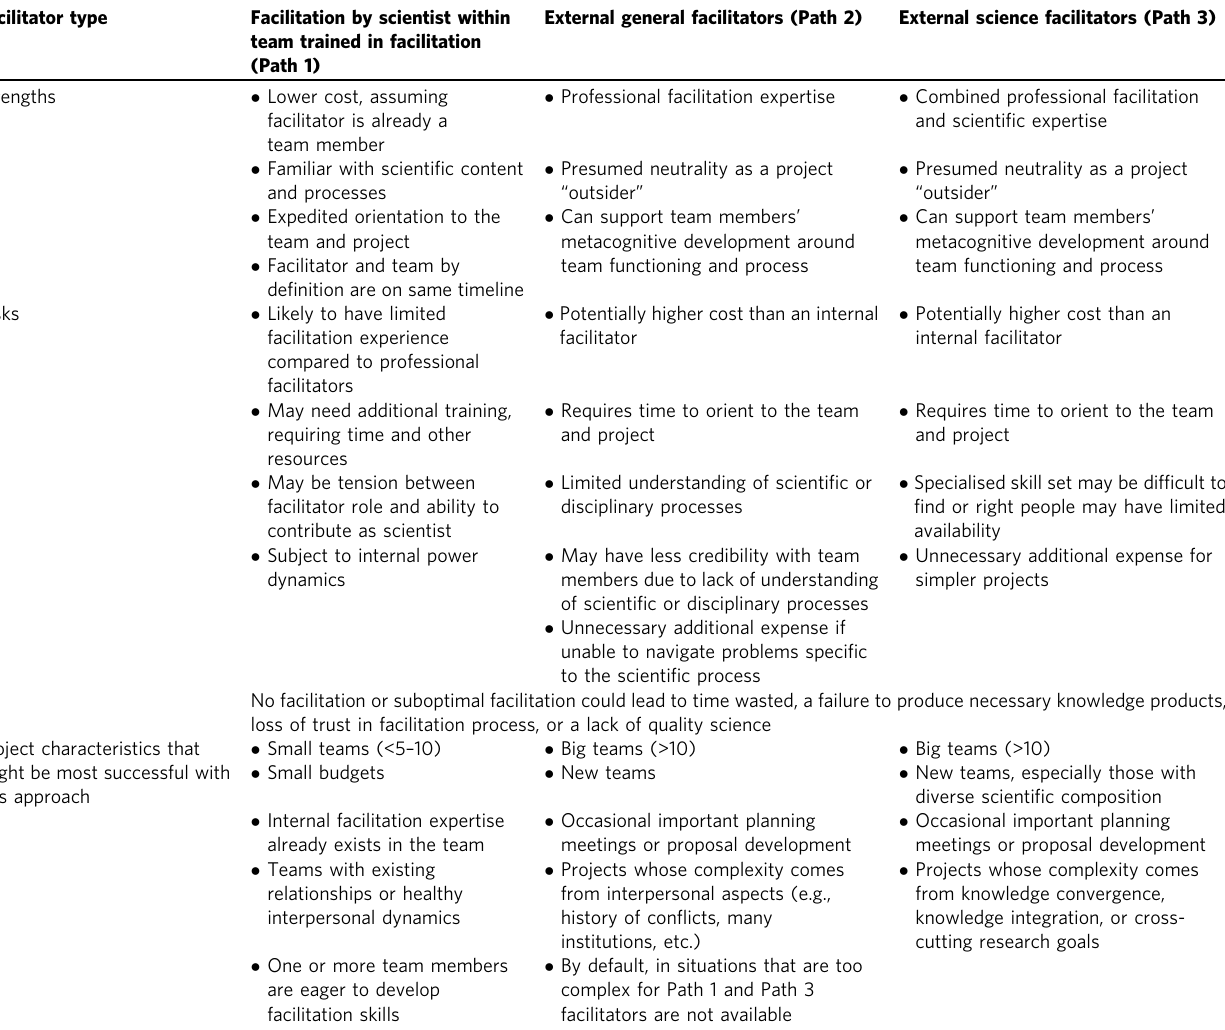
Table 2 Key qualities of the three science facilitation